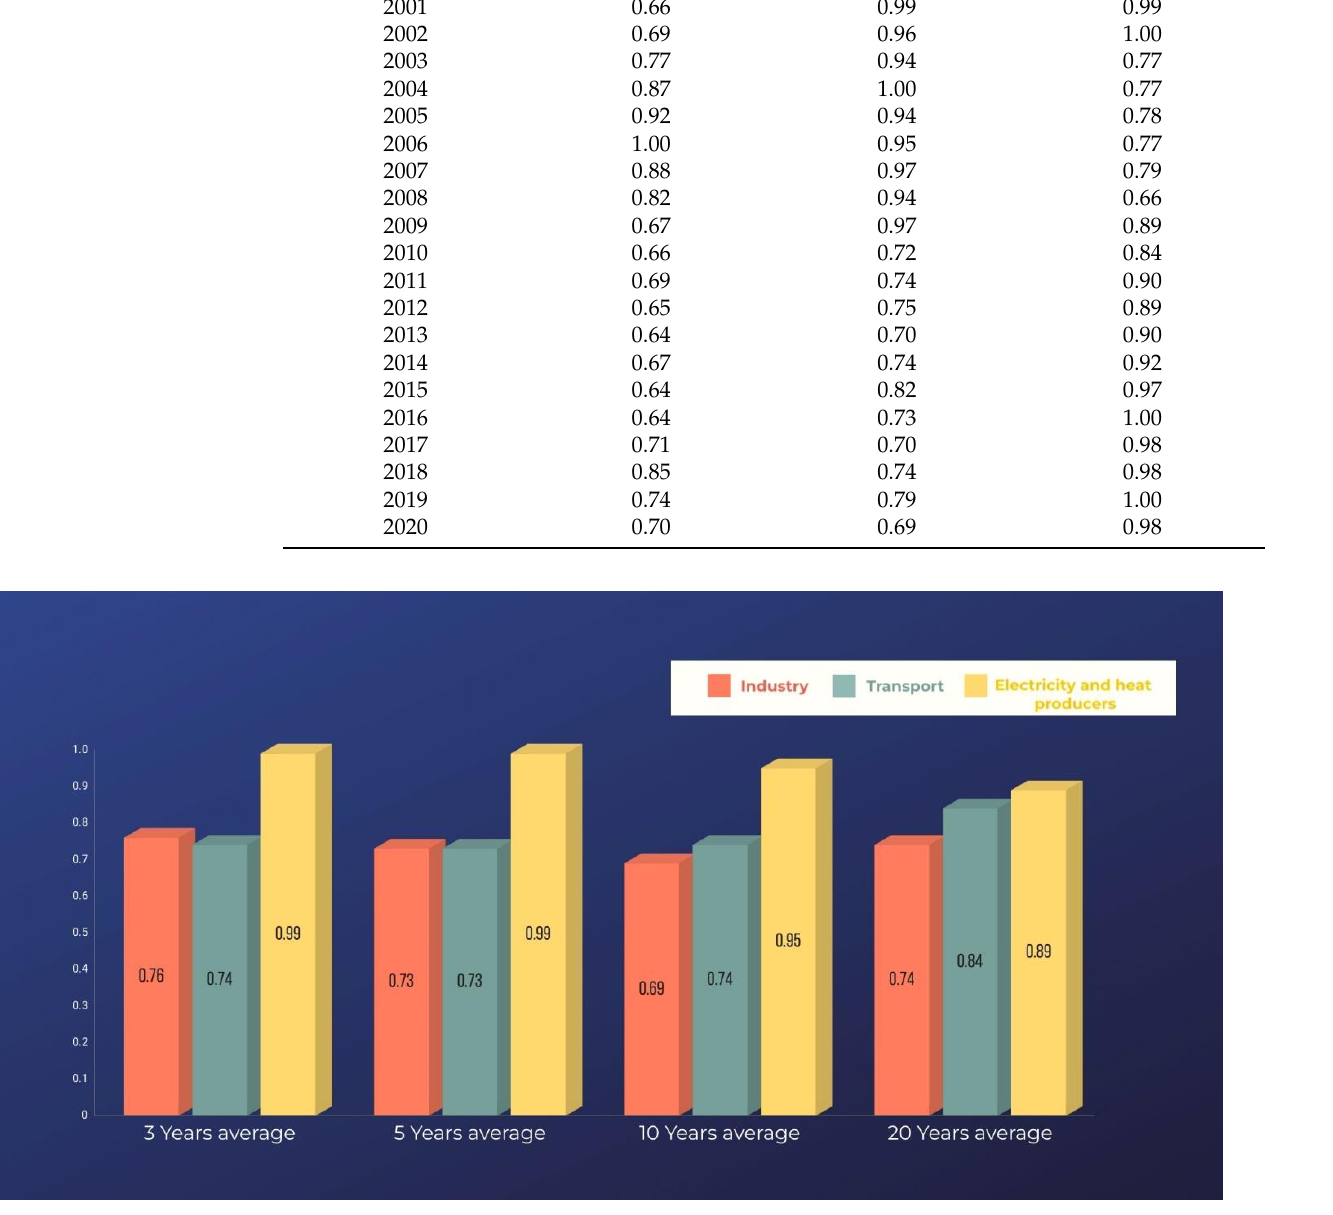
Figure 4. Average energy, economic, and environmental efficiency of UAE sectors. Table 2. Sector efficiency scores.